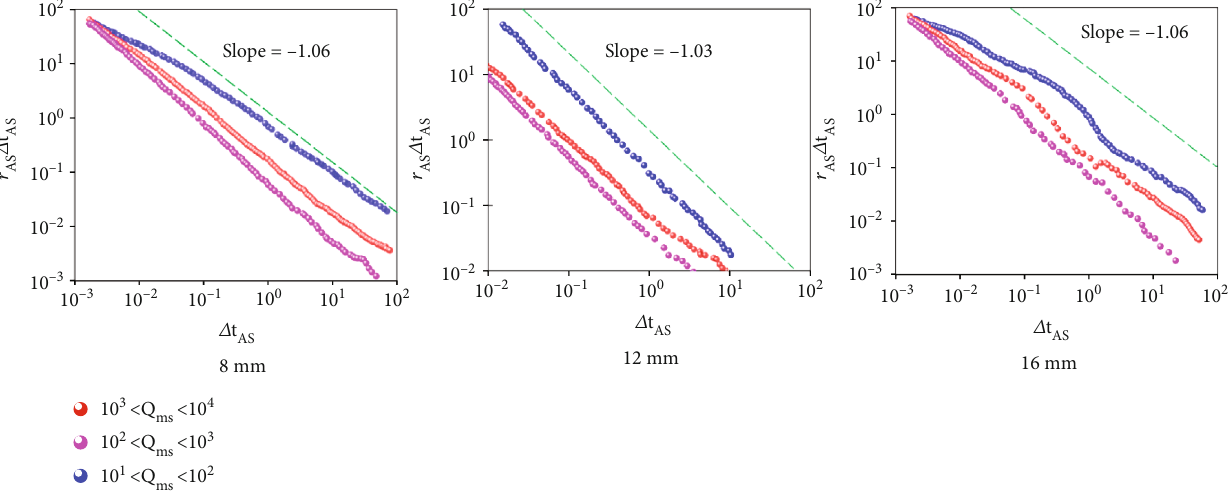
Figure 10: Distribution of aftershock sequences of specimens with di ff erent